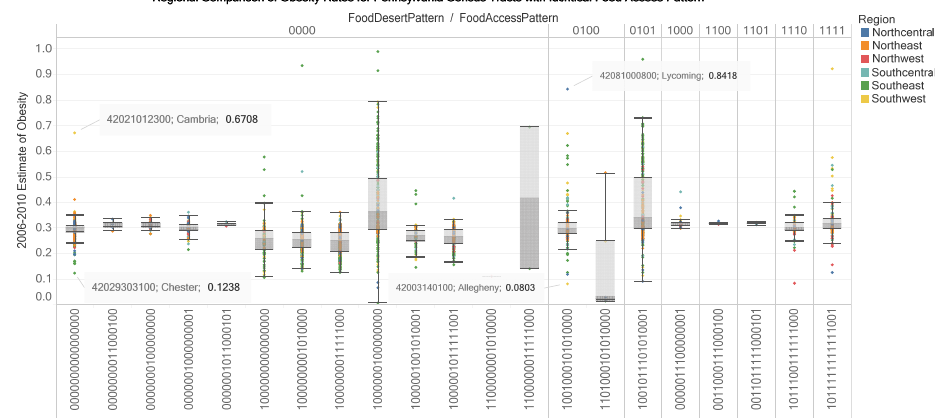
Figure 9. Regional comparison of estimates of obesity rates (2006–2010) for census tracts with the same food access pattern in Pennsylvania. We designed the box plot to support decisions on differences in obesity rates in regions. The design of the view allows one or more regions to be selected (coordination function of the knowledge visualization).